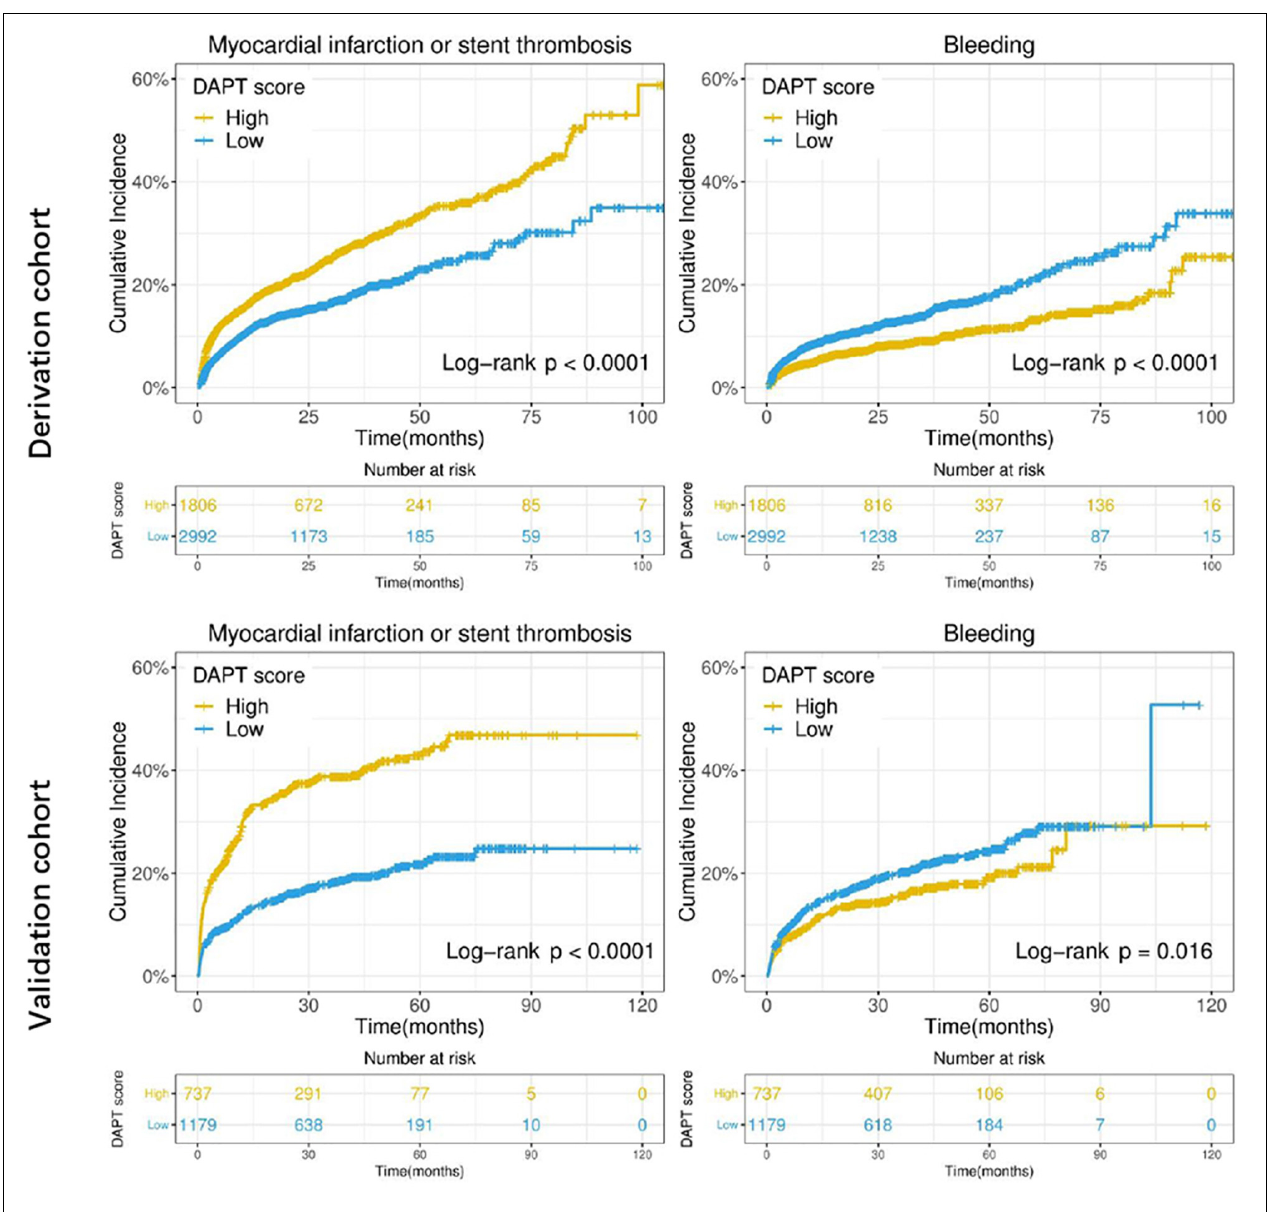
FIGURE 3 | Cumulative incidence of ischemic (myocardial infarction or stent thrombosis) and bleeding events stratified by high ( ≥ 2) vs. low ( < 2) DAPT score in the derivation and validation cohorts. The X-axis represents time (month), while the Y-axis represents cumulative cadences. P < 0.05 was considered to indicate statistically significant